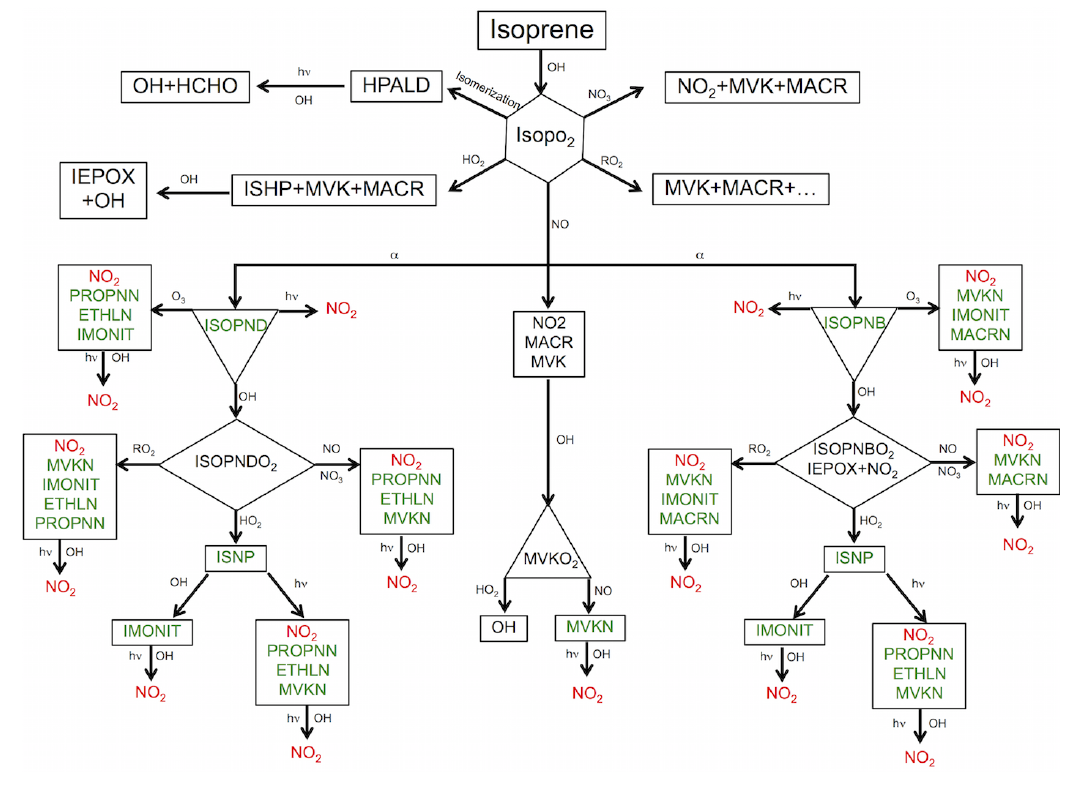
Figure 1. Schematic representation of the formation of isoprene nitrates (in green) initiated by OH oxidation. Rerelease of the consumed NO x to the atmosphere by chemical loss processes of oxidation, ozonolysis and photolysis of organic nitrate is shown in red. See Table S2 in the Supplement for species